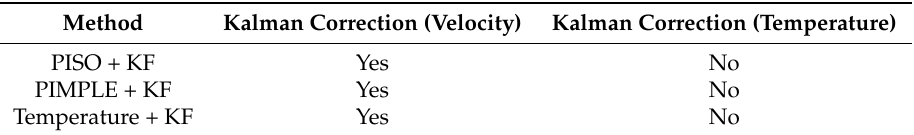
Table 1. Summary of the algorithms and